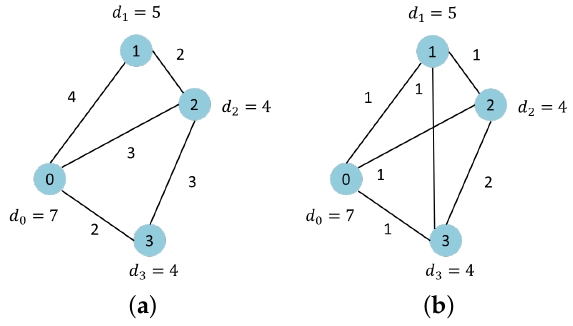
Figure 4. The influence of the duration: subfigure ( a ) shows the tasks V in graph G 1 and subfigure ( b ) shows the tasks V in graph G 2 . The principal–assistant team has 2 principal agents and each is equipped with 2 assistant agents, the duration of which is